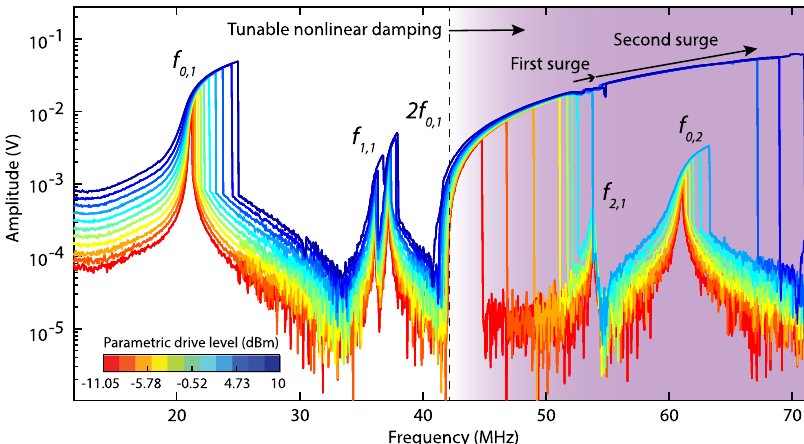
Fig. 4 Nonlinear frequency response measurements at high drive powers. The parametric resonance interacts successively with multiple directly driven modes of vibration. The arrows in the fi gure show successive amplitude – frequency surges. Starting from the dashed line, shaded area represents the region where nonlinear damping is